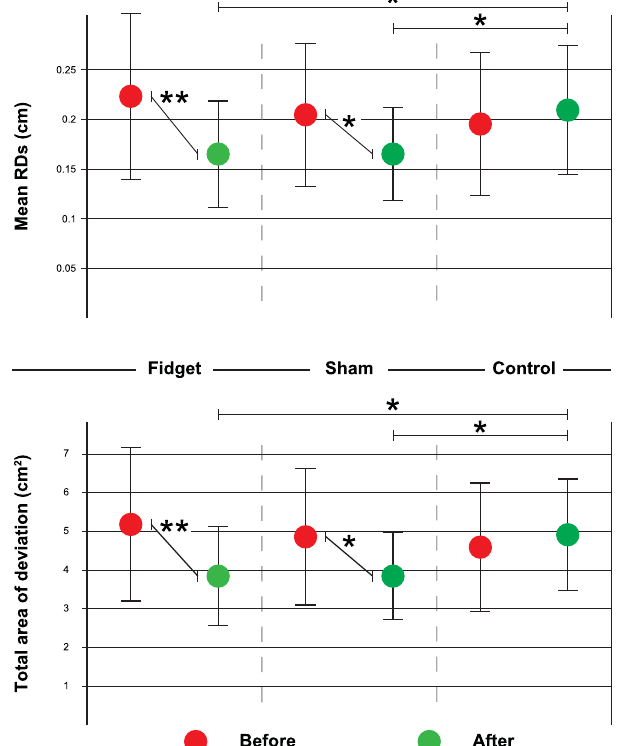
Figure 4. Results. Circles represent the group mean and vertical bars indicate the standard deviation. Circles are color coded according to trial (red for Before, green for After). It is possible to see that for both Fidget and Sham groups there is a significant improvement in the After trial with p-values < 0.01 ( ** ) for the Fidget group and < 0.05 ( * ) for the Sham group for both mean RD (upper panel) and total area of deviation (lower panel). Also, it is possible to see a significant difference in the After trial, for both mean RD and total area of deviation, between Fidget and Control groups and Sham and Control groups with p-values < 0.05 ( * ), but not between Fidget and Sham